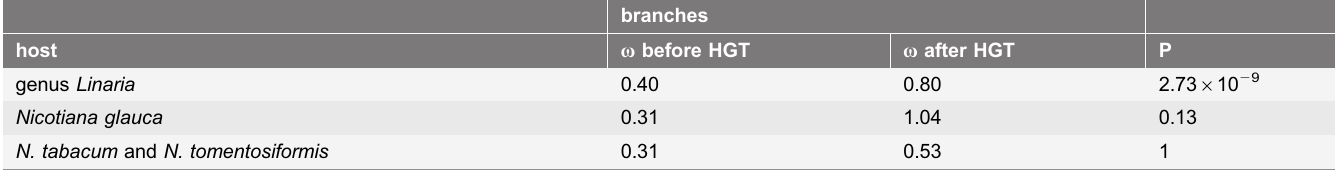
Table 1. Branch analysis of mikimopine synthase evolution before and after HGT.